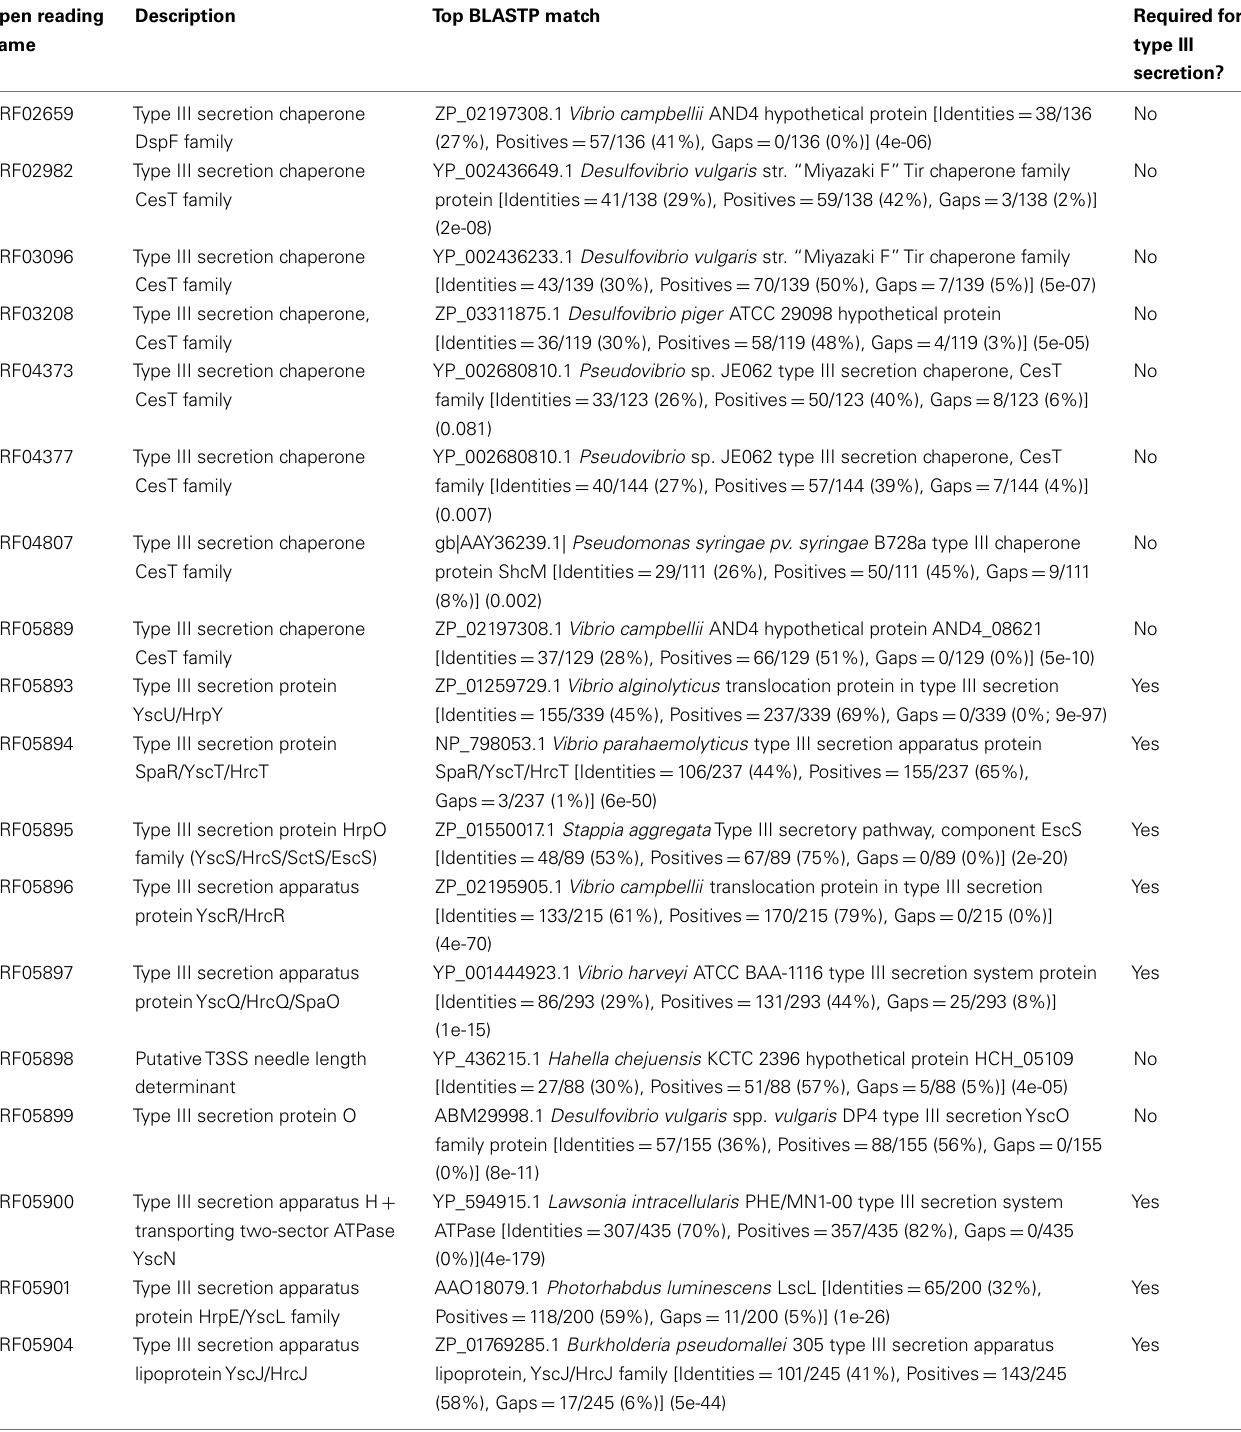
TableA1 |Type III Secretion System structural genes and chaperones in the V. spinosum genome, predicted on the basis of primary sequence similarity (BLASTP comparison) and domain